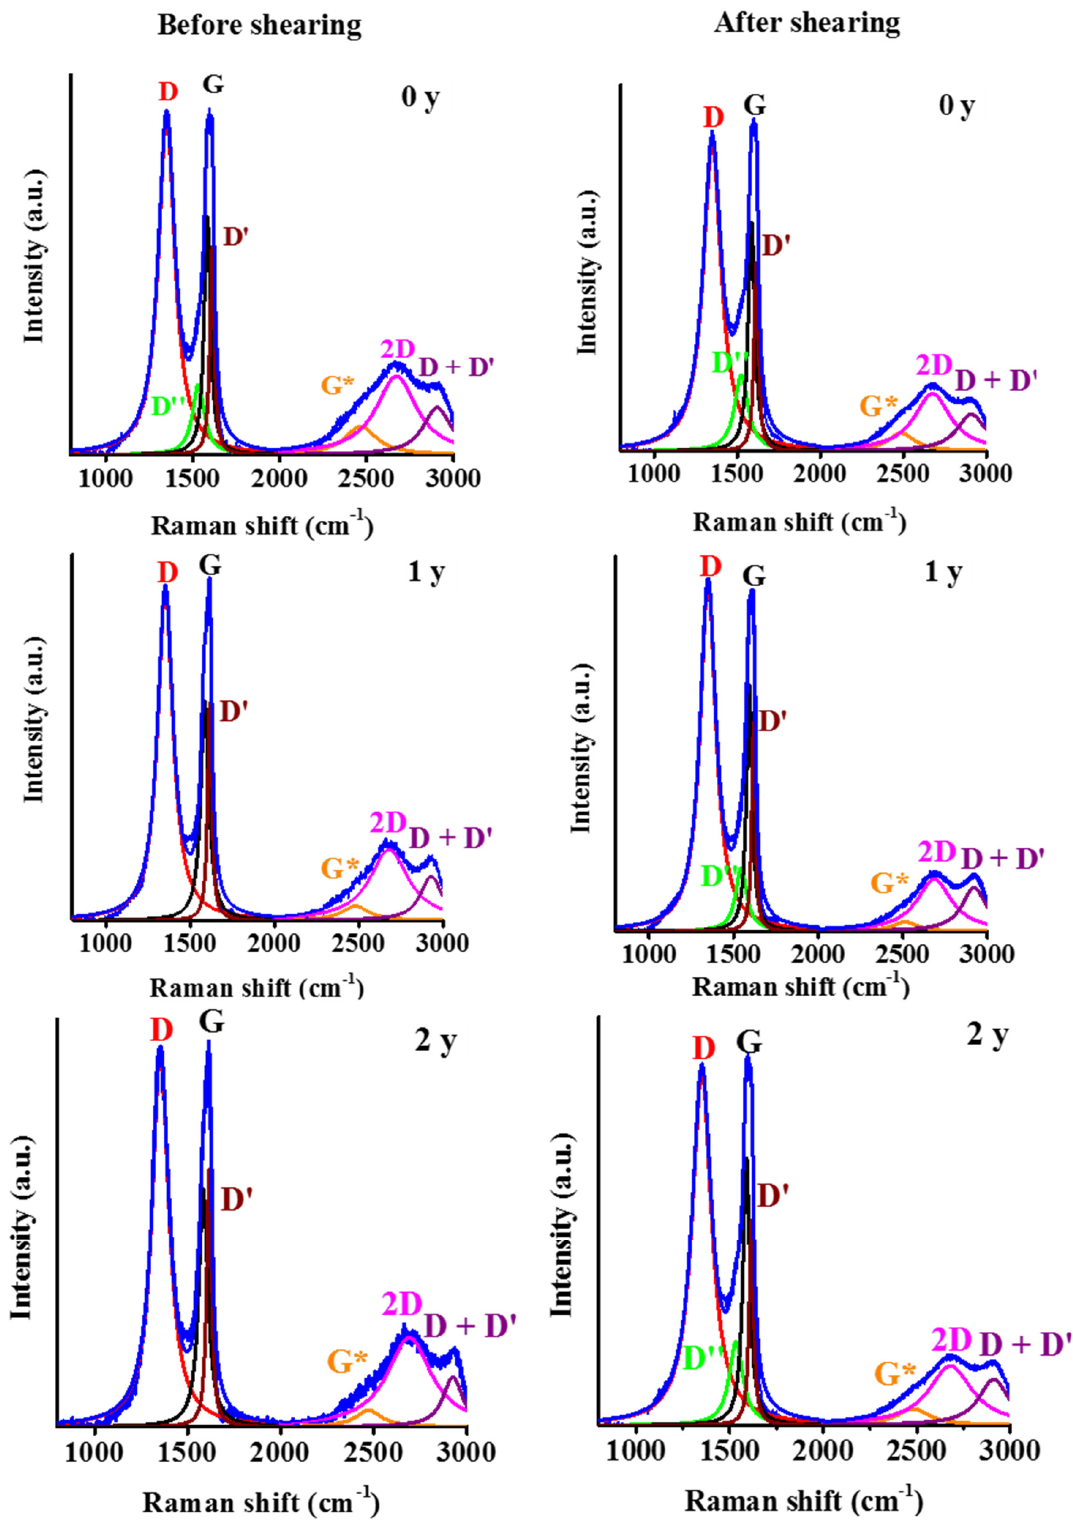
Figure 13. Deconvoluted Raman spectra of the samples of different ages before and after shearing. While the position of the D and G bands remain constant, only the 2D exhibits a sys- tematic increase, i.e., a blue shift on going from year 0 to year 2. The wide 2D peaks indi- cate that the particles contain several layers and the planes may be randomly oriented. The intensity ratio I D / I G is the hallmark of the defects, i.e., the extent of the sp 2 domain size